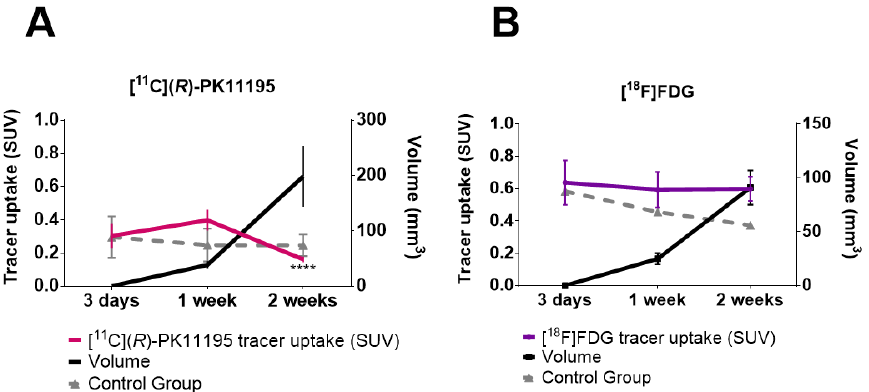
Figure 4. Tumor volume and tracer uptake: ( A ) [ 11 C]( R )-PK11195 uptake in tumor group (red) at 3 days ( n = 4), 1 week ( n = 20), and 2 weeks ( n = 12), and in the control group (gray) at 3 days ( n = 6), 1 week ( n = 4), and 2 weeks ( n = 4); and ( B ) [ 18 F]FDG PET uptake in the tumor group (purple) at 3 days ( n = 5), 1 week ( n = 5), and 2 weeks ( n = 4), and in the control group (gray) at 3 days ( n = 7), 1 week ( n = 6), and 2 weeks ( n = 6). (**** p < 0.0001; decreased [ 11 C]( R )-PK11195 uptake in 2 weeks compared to 1 week time point, Mann – Whitney U test).